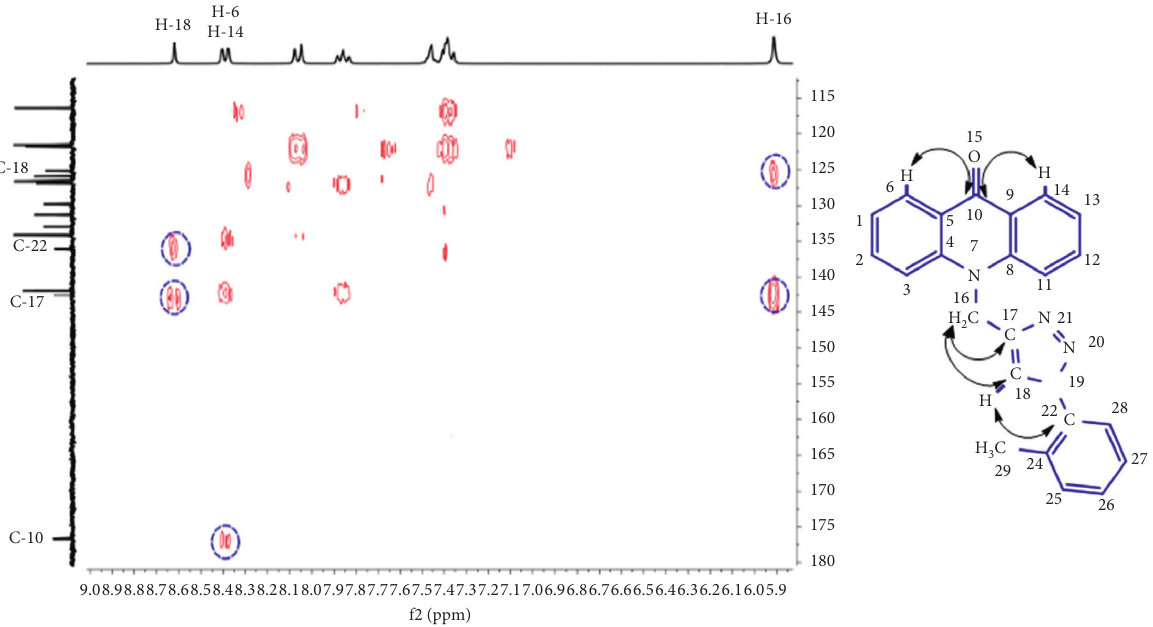
Figure 3: The 1 H- 13 C HMBC spectrum of compound 2a.